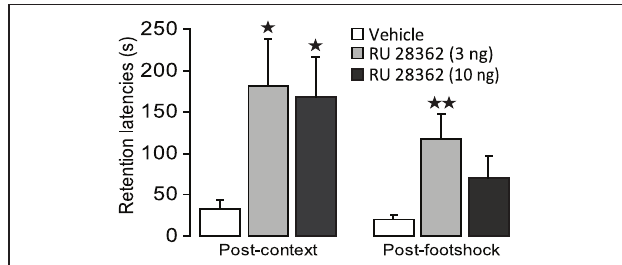
FIGURE 3 | Glucocorticoid receptor agonist infusions into the insular cortex enhance memory consolidation of both the context and footshock components of inhibitory avoidance training. Step-through latencies (mean ± SEM) in seconds on the 48h inhibitory avoidance retention test of rats given bilateral infusions of the glucocorticoid receptor agonist RU 28362 (3 or 10ng in 0.5 μ l) into the insular cortex immediately after either context or shock training on the two-phase modified inhibitory avoidance task ( n = 12–14 per group). ∗ p < 0 . 05, ∗∗ p < 0 . 01, as compared with the corresponding vehicle-treated group.